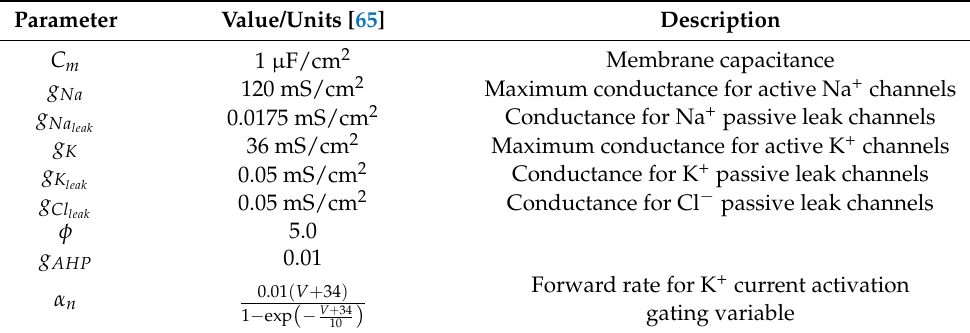
Table 7. Parameter values for membrane potential